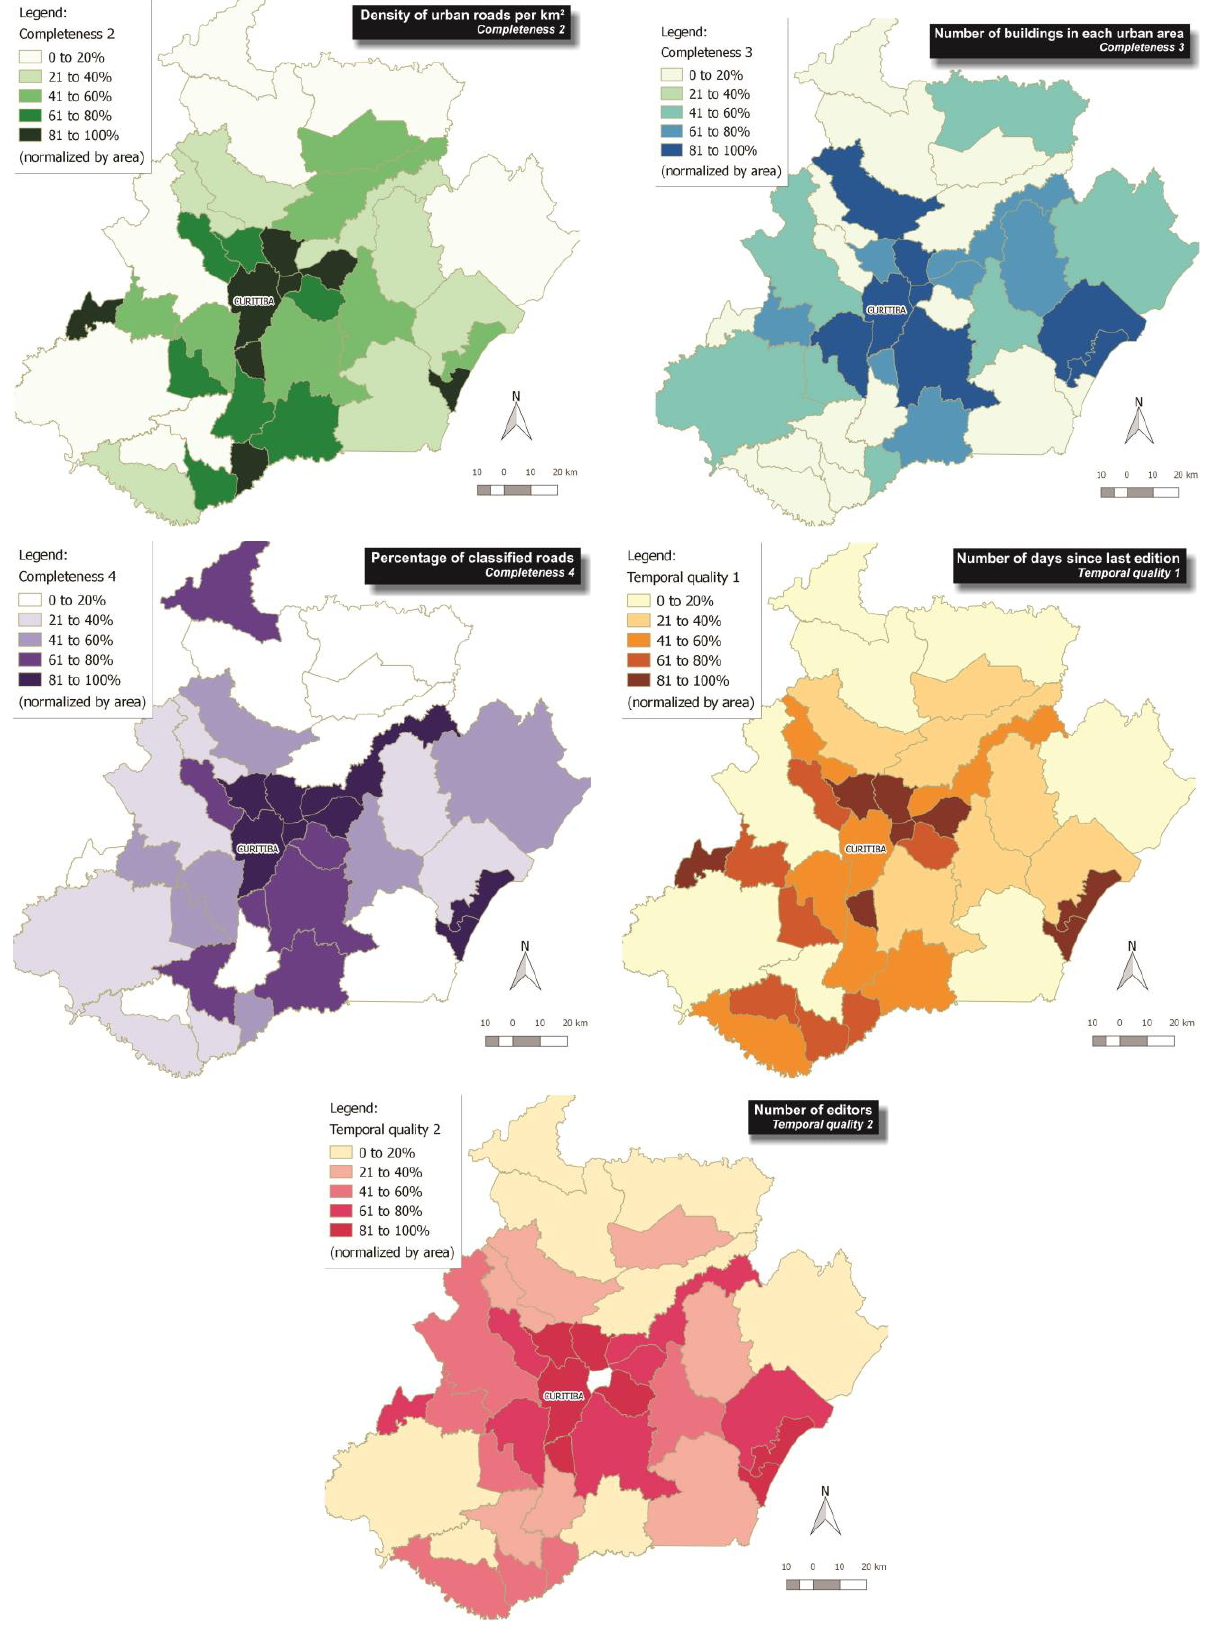
Figure 7. Five data quality elements in urban